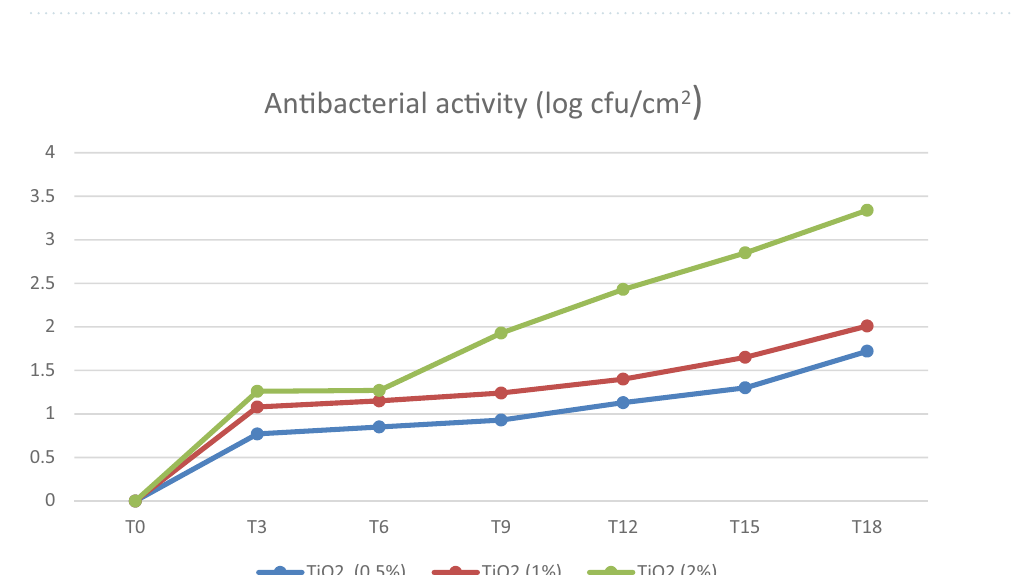
Figure 2. Antibacterial activity of TiO2 nanoparticles against S.